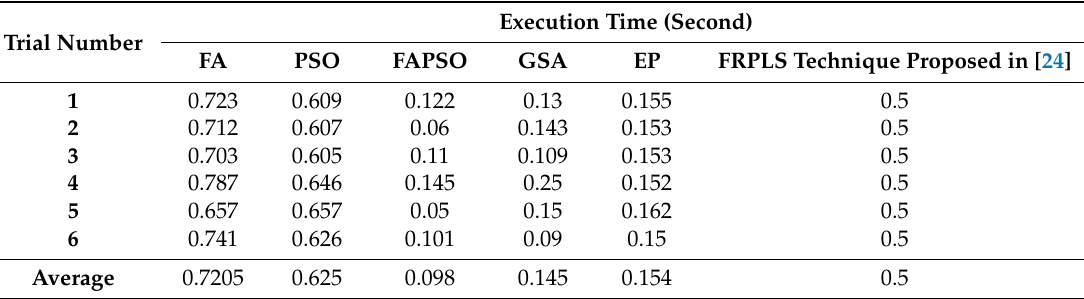
Table 8. The execution time for different load shedding